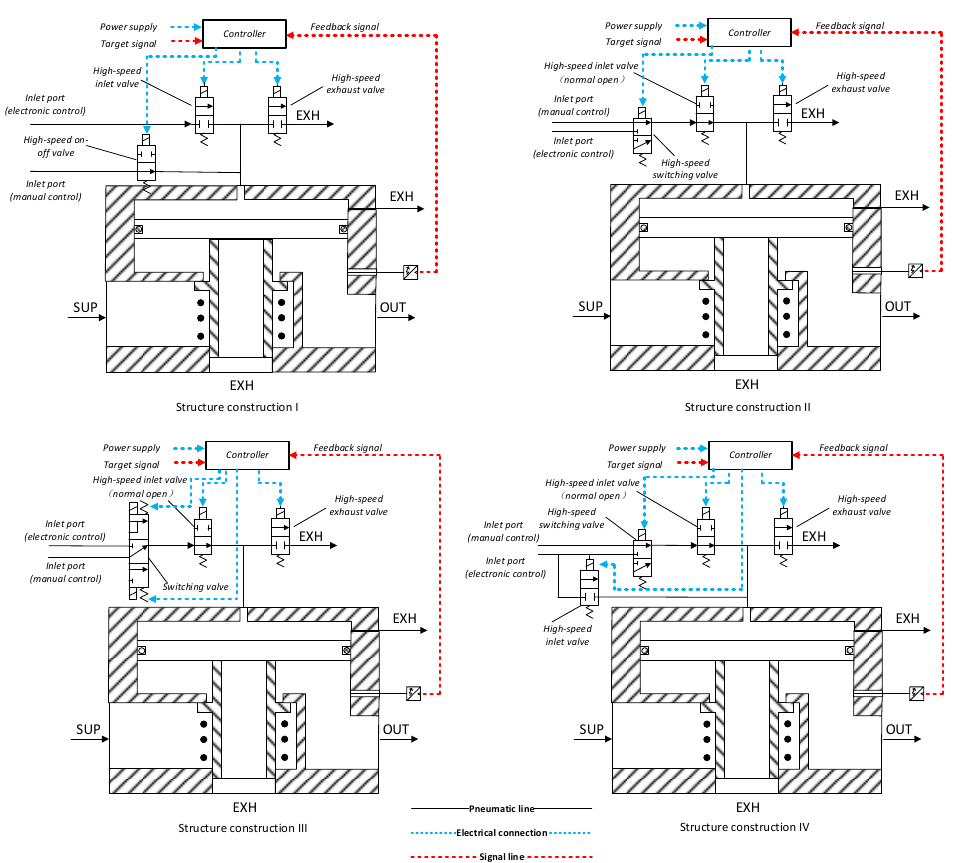
Figure 2. Principle drawing of the different structural configurations of the APRV.